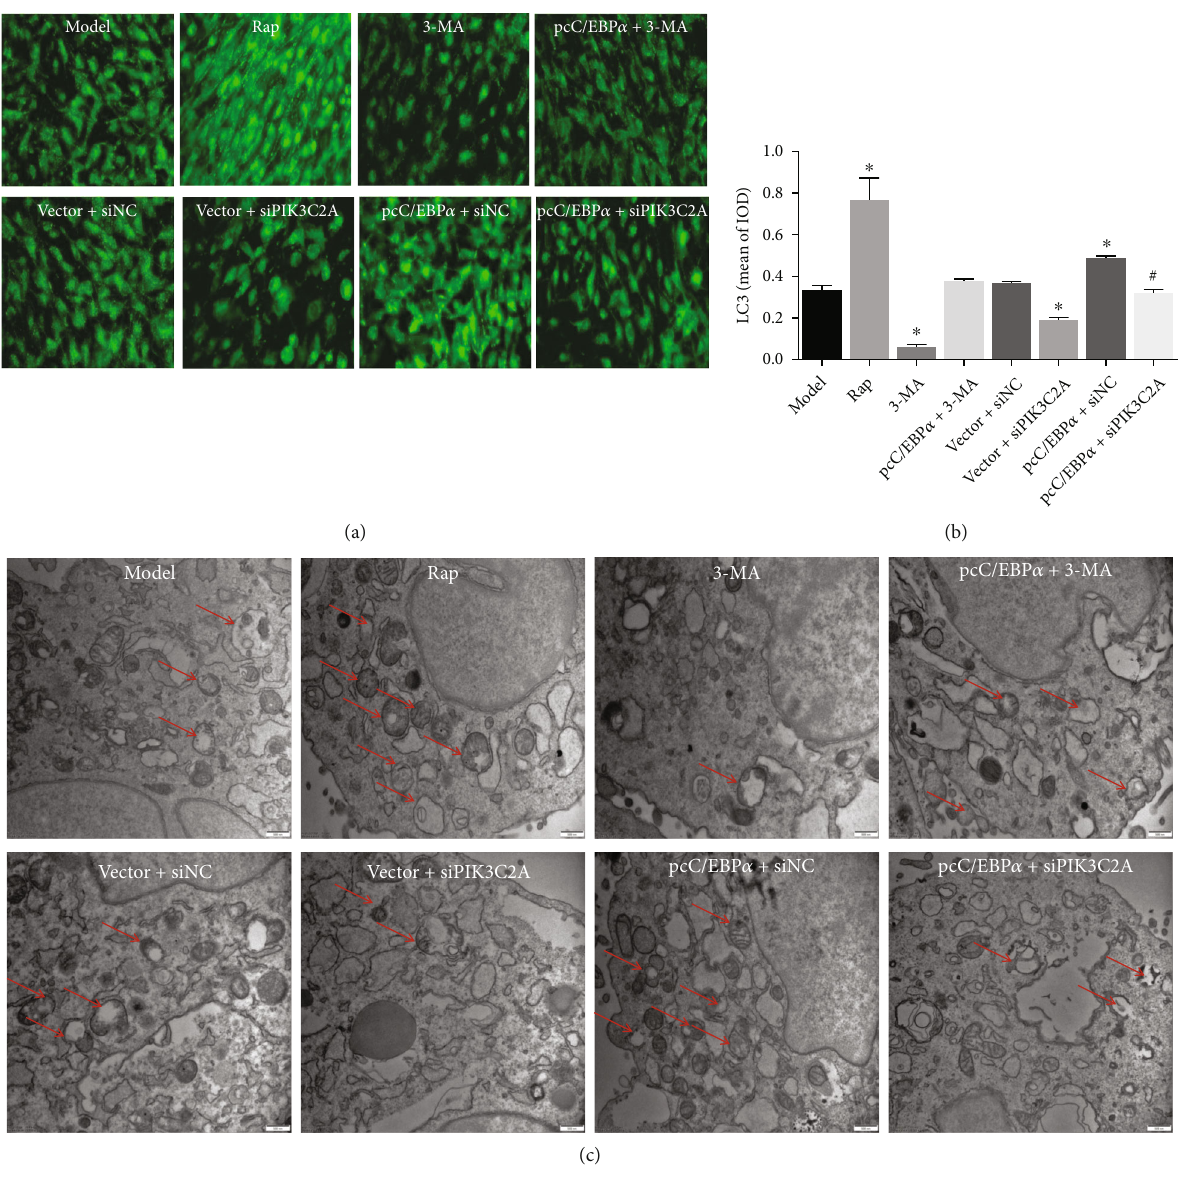
Figure 8: The formation of LC3 puncta and autophagosome varied with C/EBP α , PIK3C2A, and autophagy in angiotensin II-treated VSMCs. Representative LC3 puncta images (a) of Ang II-treated VSMCs and the quantitation of LC3 IOD (b) of positive cells. (c) The autophagosome in each group observed using the TEM. Model: treated with 1 μ M Ang II; Rap: cotreated with 1 μ M Ang II and 0.25 μ M rapamycin; 3-MA: cotreated with 1 μ M Ang II and 5 mM 3-methyladenine; pcC/EBP α +3-MA: cotreated with 1 μ M Ang II and 5mM 3- methyladenine in C/EBP α -overexpressed VSMCs; vector+siNC: treated with 1 μ M Ang II in pcDNA3.1 and siRNA NC cotransfected VSMCs; vector+siPIK3C2A: treated with 1 μ M Ang II in pcDNA3.1 and PIK3C2A siRNA cotransfected VSMCs; pcC/EBP α +siNC: treated with 1 μ M Ang II in pcC/EBP α and siRNA NC cotransfected VSMCs; pcC/EBP α +siPIK3C2A: treated with 1 μ M Ang II in